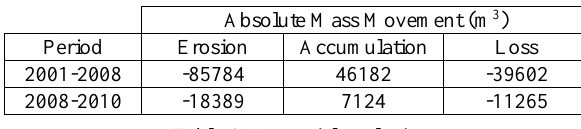
Table 8: Numerial analysis